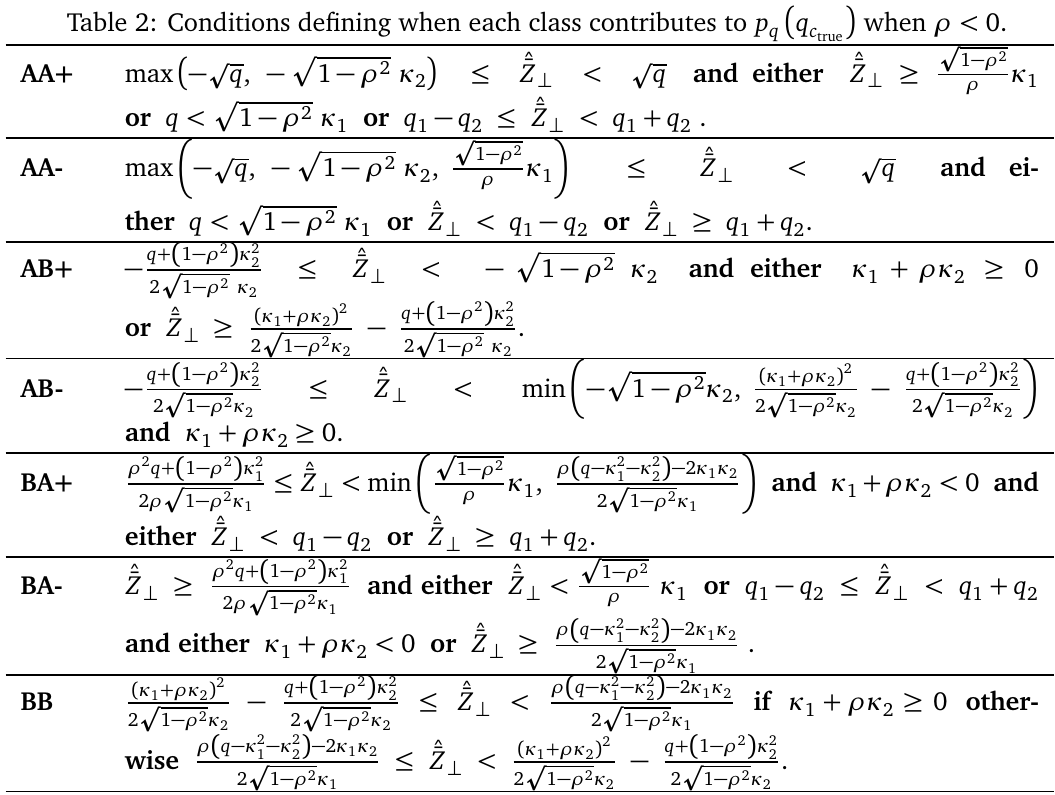
(cid:0) (cid:1) q when ρ < 0. q c true